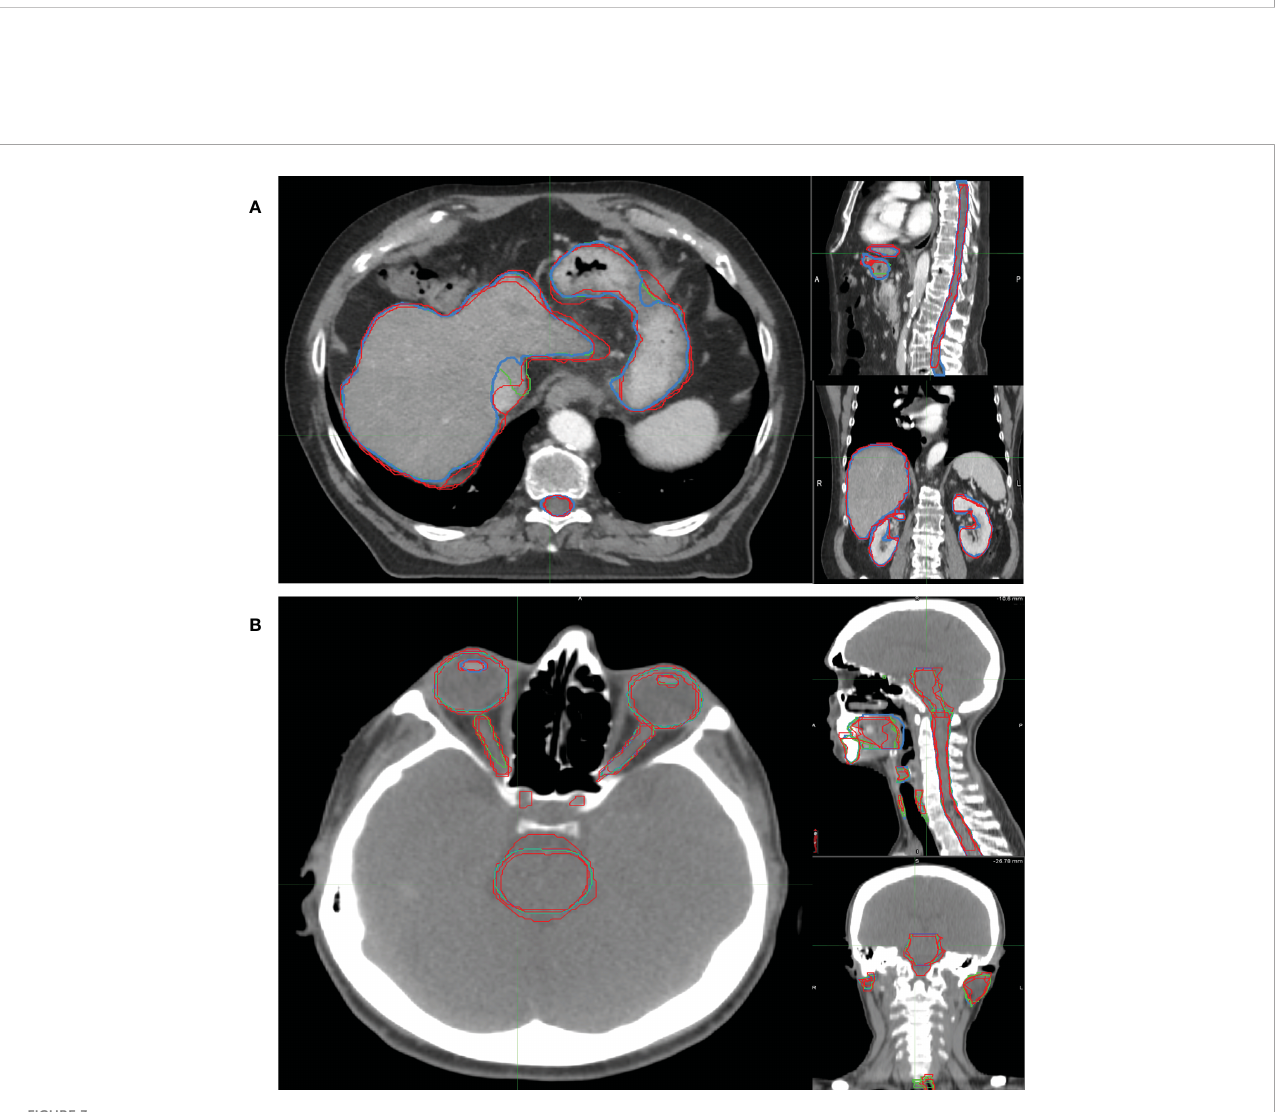
FIGURE 3 Examples of OARs delineated in axial (left), sagittal (right up) and coronal (right down) view of illustrative (A) abdominal and (B) H&N cancer patient. The blue, red and green lines rep-resent the OARs delineated by MV, MD and MD & MV, respectively. See the de fi nition of Figure 1